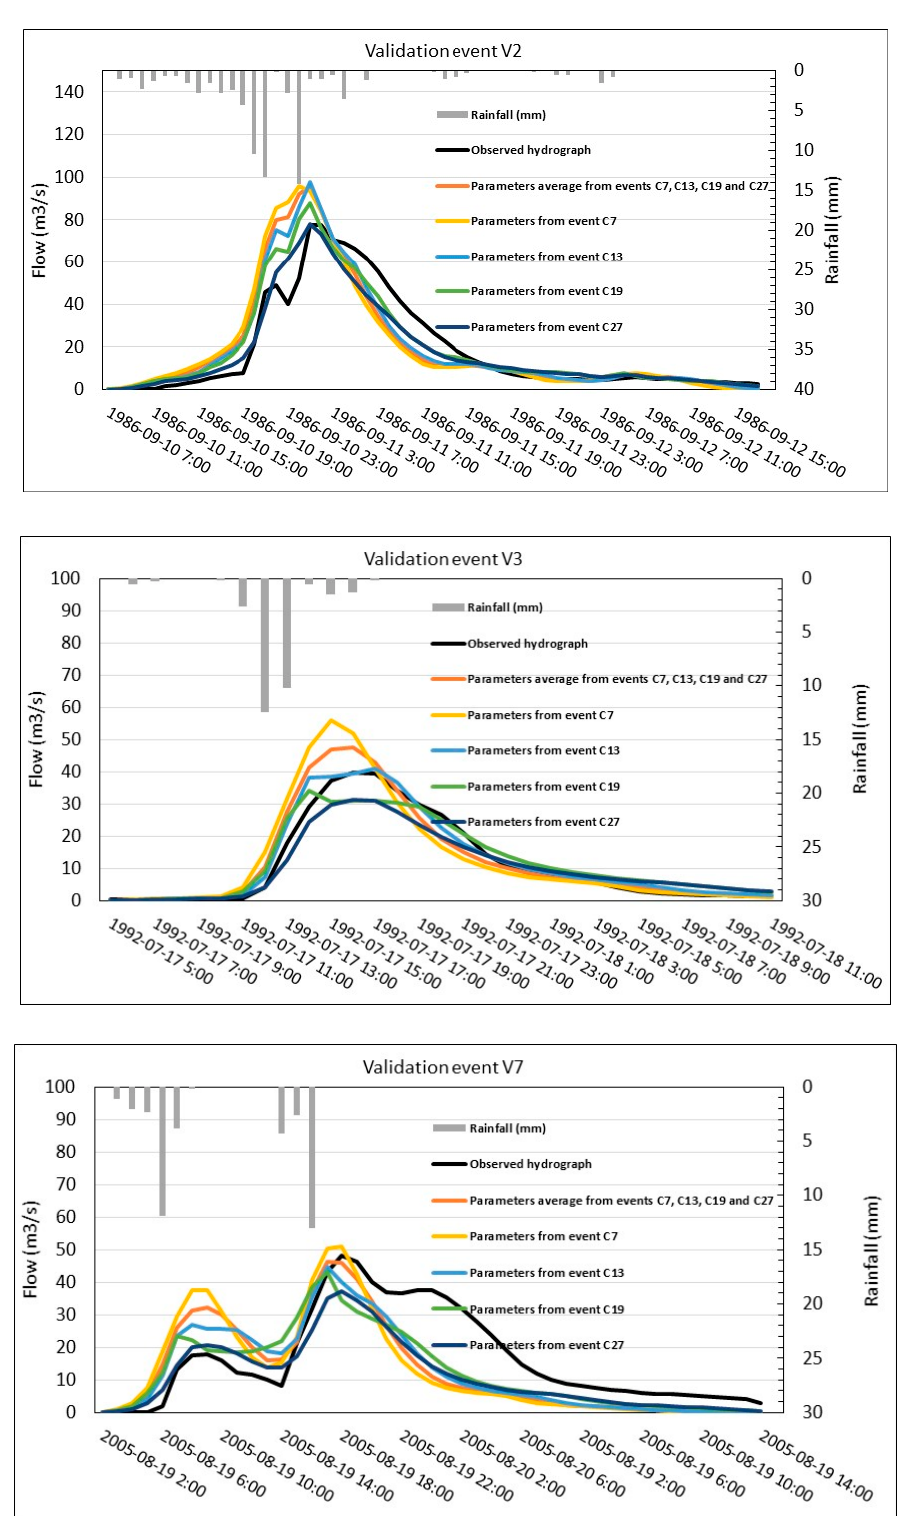
Figure 3. Comparison of the observed hydrographs for the validation events with the simulated hydrographs from the calibration events.